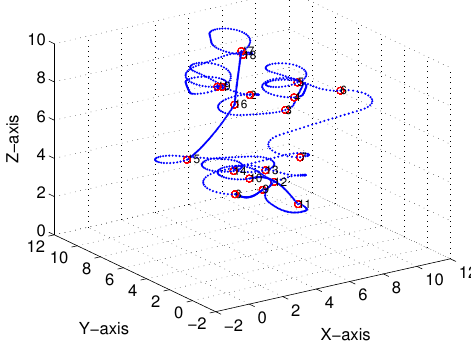
Figure 19. Bezier interpolation based three-dimensional (3D) Dubins curves (case